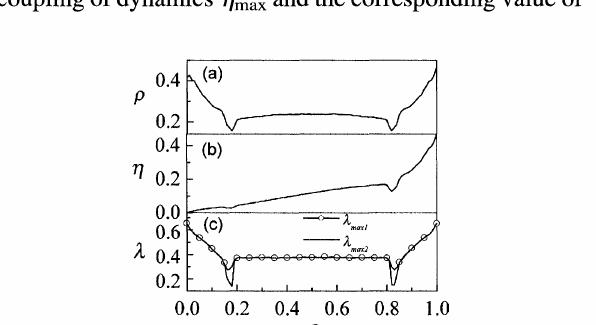
Characterization ofthe coupling of dynamics and Lyapunov exponents for various coupled parameter when M 101. (a) The degree of asynchronization among mean fields p, (b) the coupling of dynamics and (c) the two largest Lyapunov exponents maxl and/max2 (maxl > Amax2 versus coupled parameter